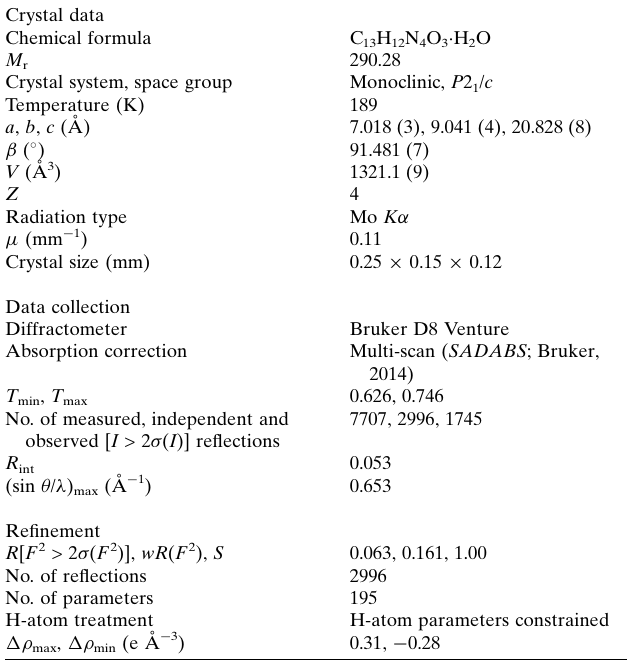
Table 2 Experimental details. Crystal data Chemical formula